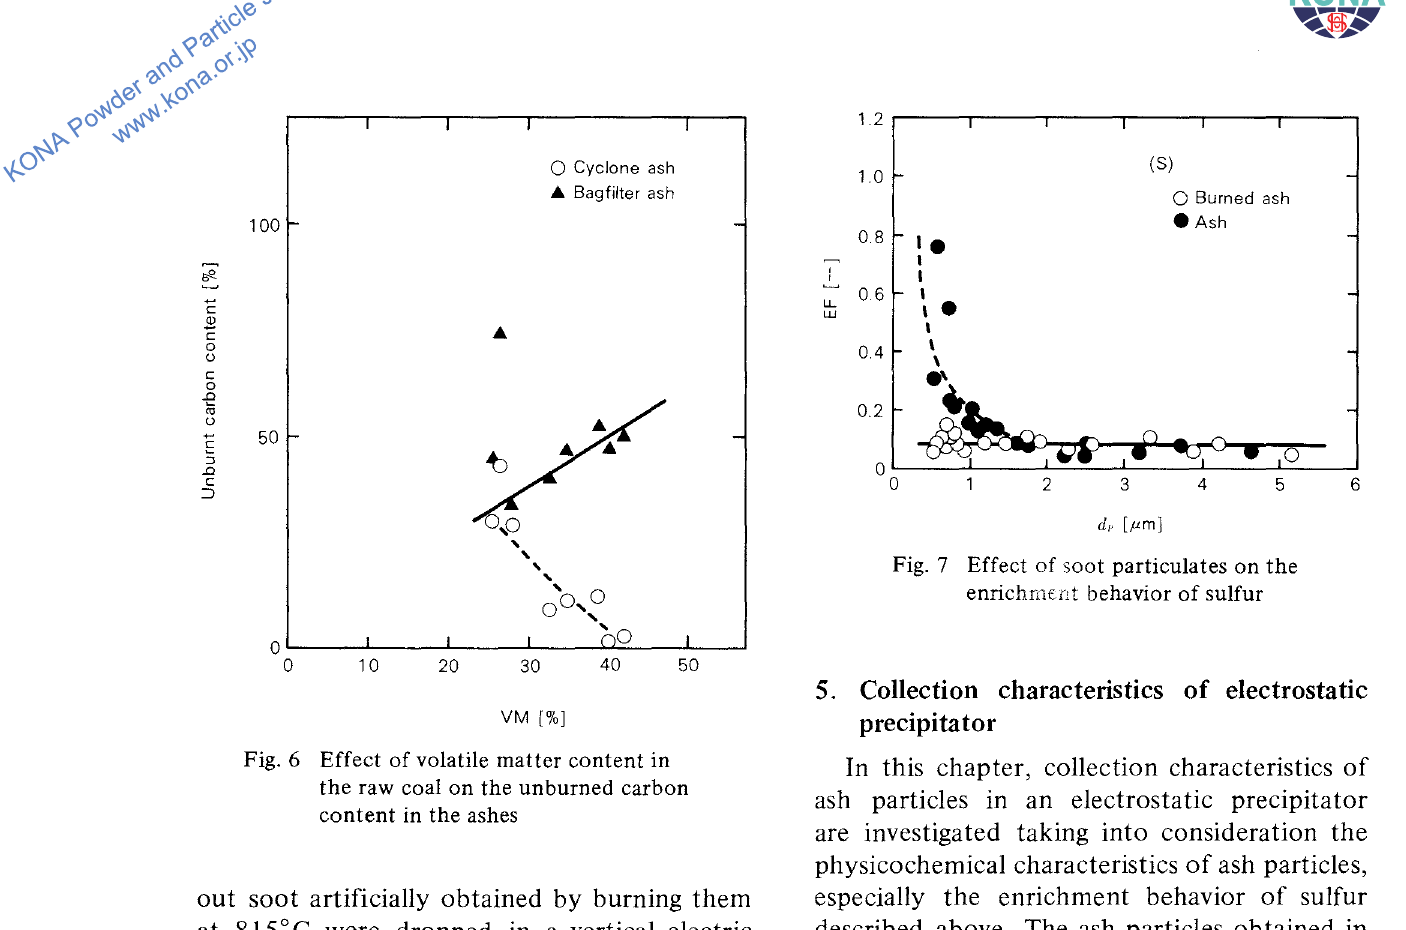
Fig. 6 Effect of volatile matter content in the raw coal on the unburned carbon content in the ashes